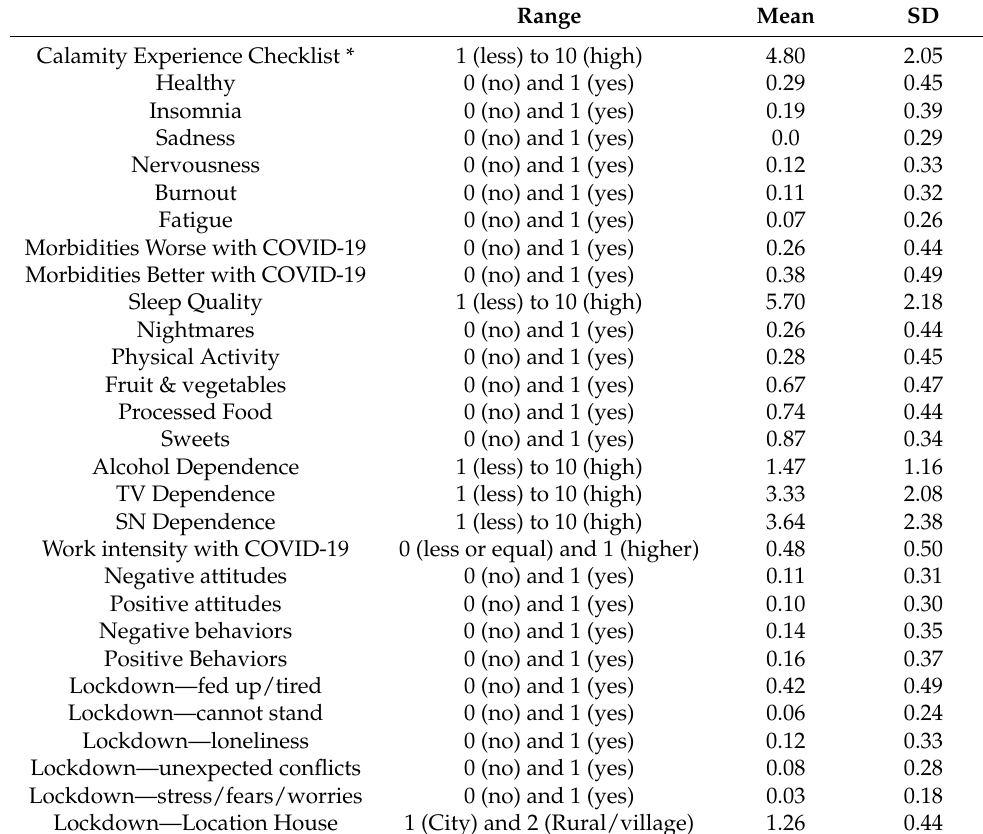
Table 1. Descriptive variables (range, mean, and standard deviation